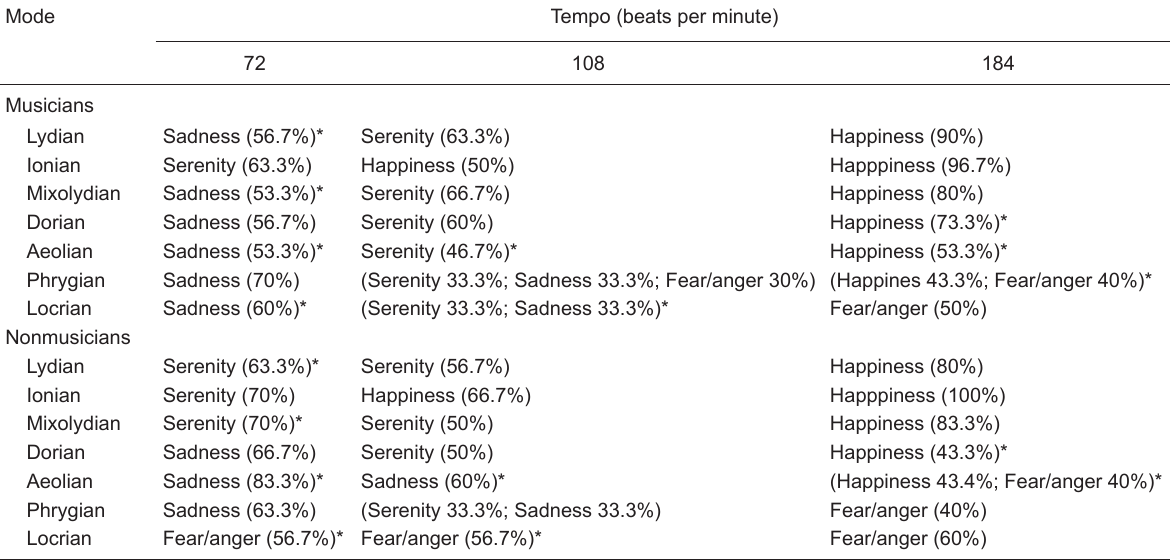
Table 1. Emotions most frequently chosen by musicians and nonmusicians listening to three pieces in different modes and tempi. Mode